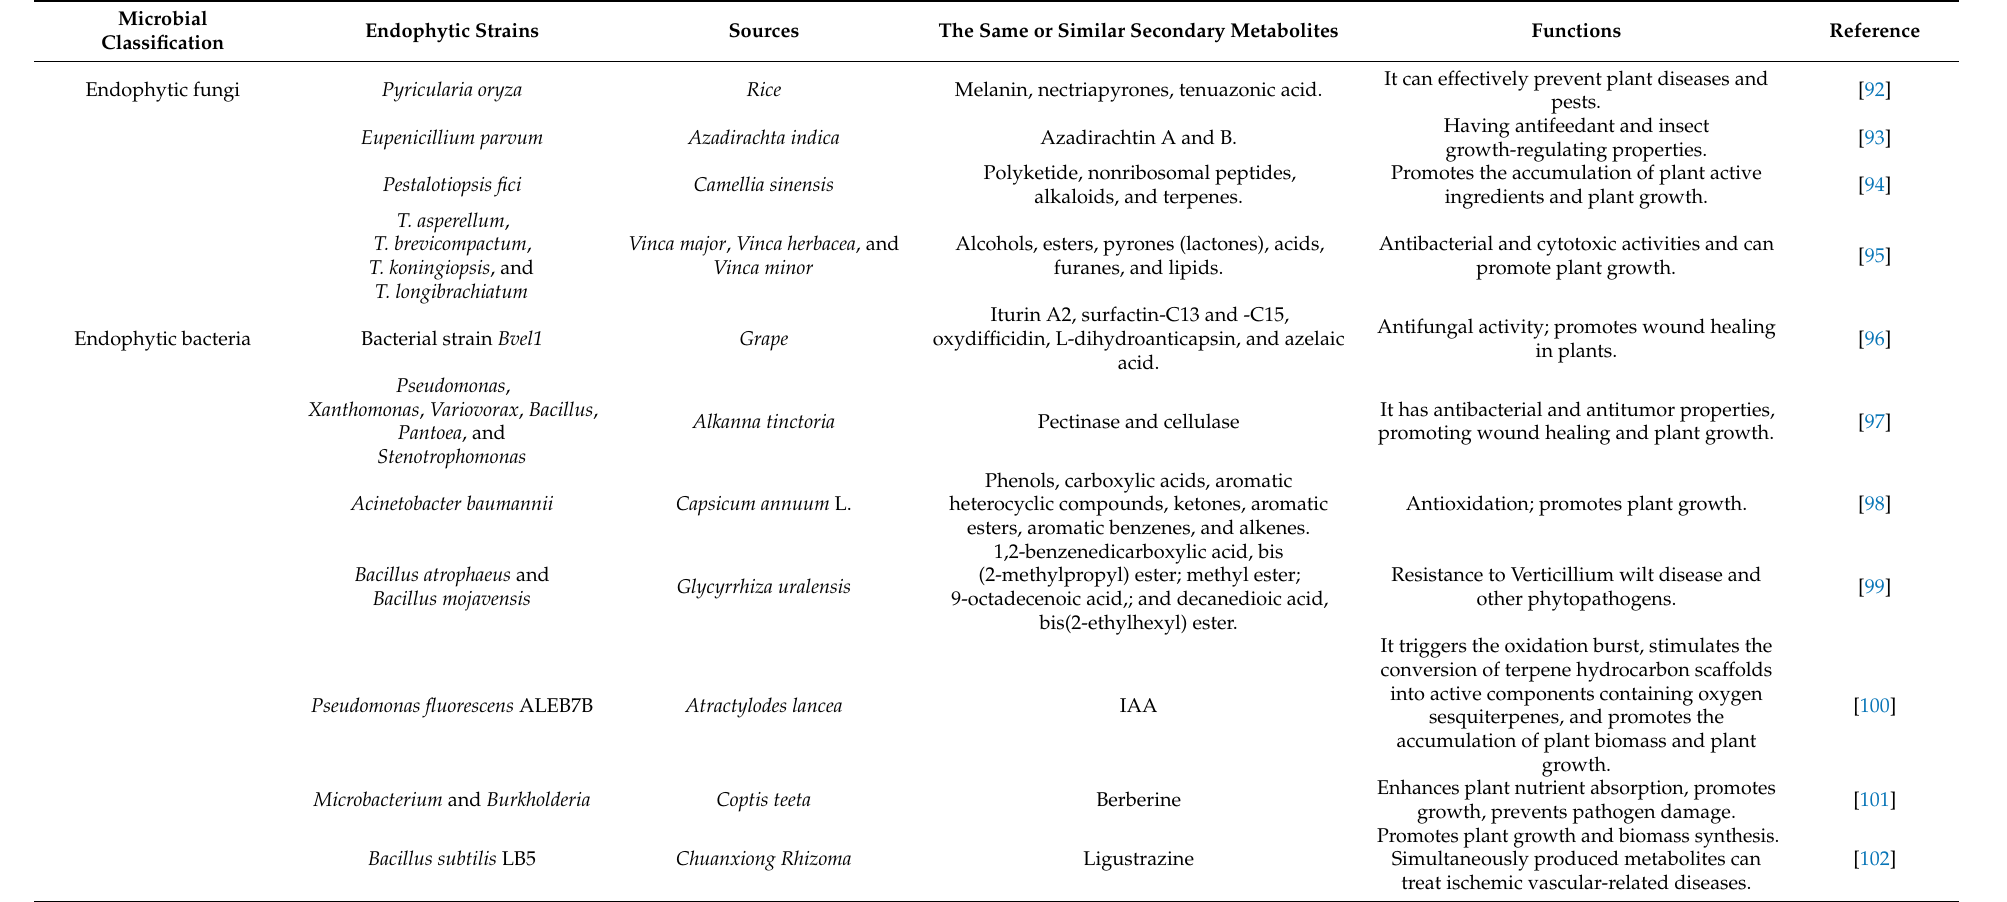
Table 3. Endophytes produce the same or similar secondary metabolites as the host